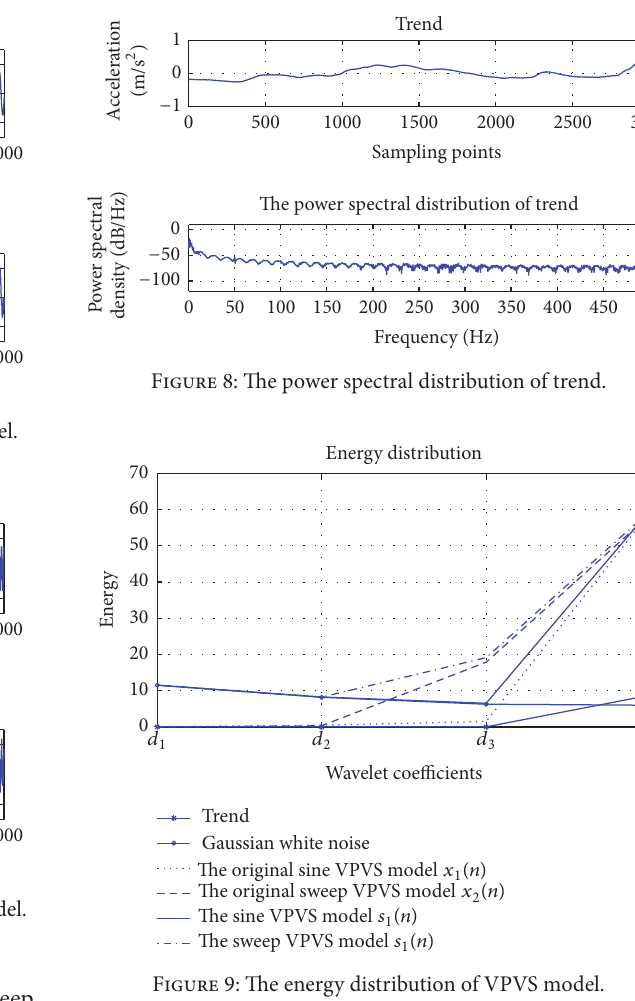
Figure 9: The energy distribution of VPVS